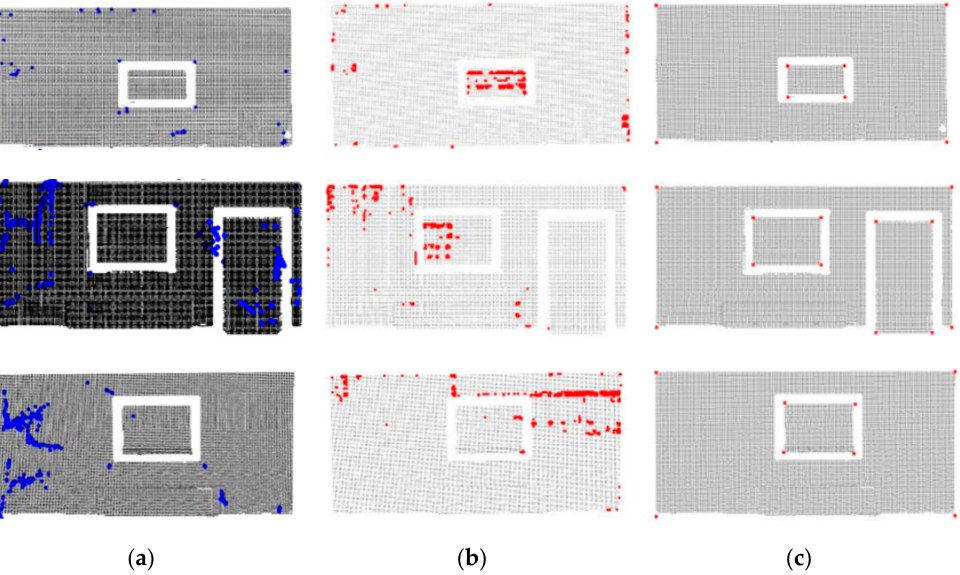
Figure 12. Comparison of corner detection results. ( a ) Harris-based method; ( b ) curvature-based method; ( c ) our method. Table 3. Corner detection time of different methods.